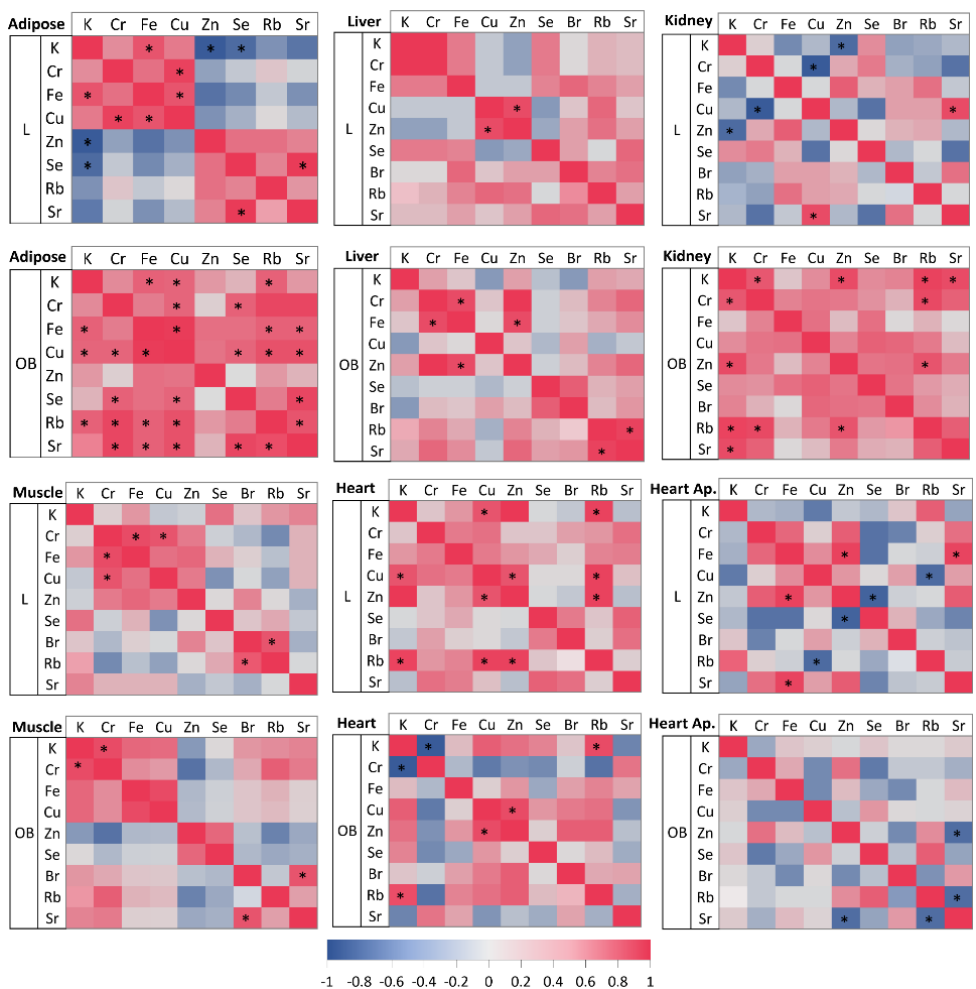
Figure 5. Pearson’s or Spearman’s correlation coefficients for elemental relationships in organs and tissues for lean intact (L) and obese (OB) groups. * — statistically significant correlation (at the p - levels < 0.05).